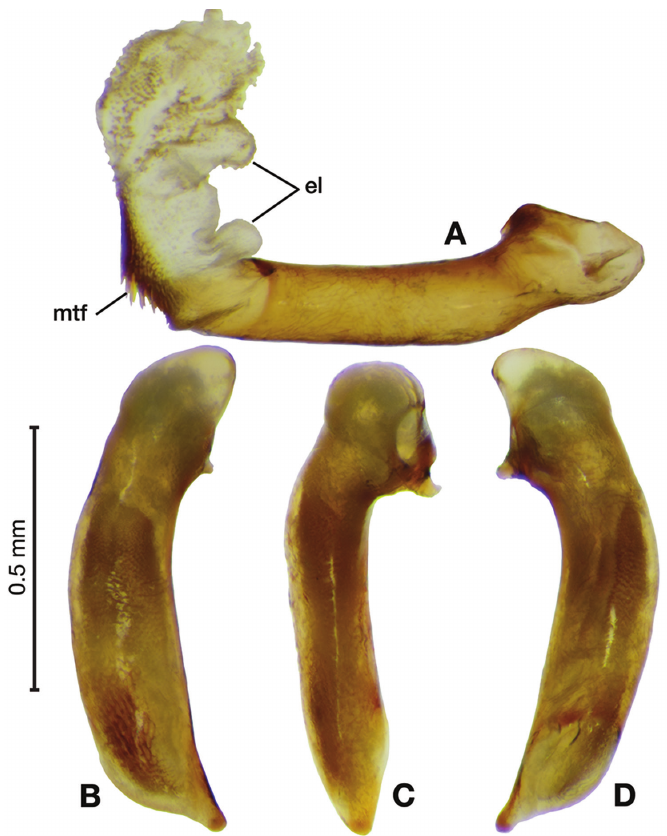
Figure 101. Digital images of male genitalia of Mochtherus tetraspilotus (MacLeay). A left lateral aspect, endophallus everted B right lateral aspect C ventral aspect D left lateral aspect. Legend: el , endophallic lobe; mtf microtrichial